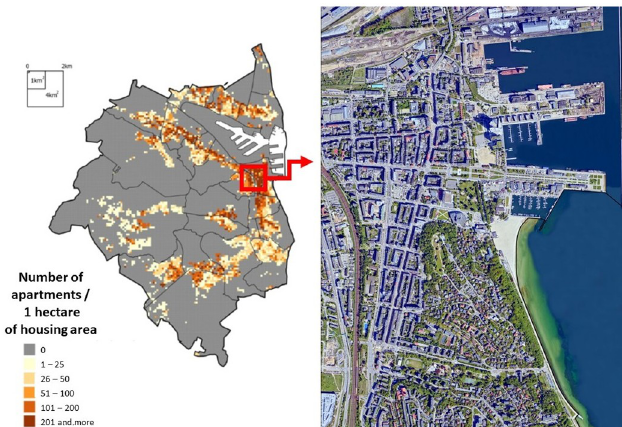
Fig 2. City of Gdynia and its central area as the place of the research. Source : self-study based on the [57] and OpenStreetMap .